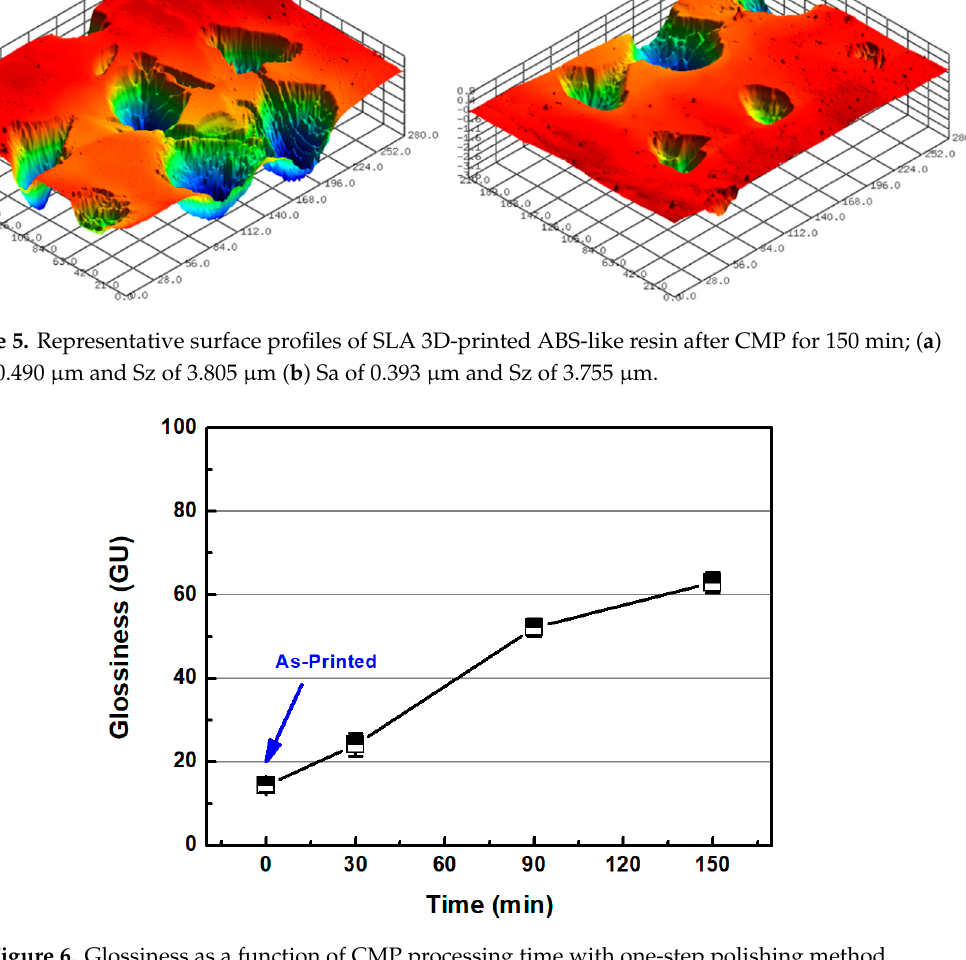
Figure 7. Schematic diagram of ABS-like resin CMP in one-step polishing.